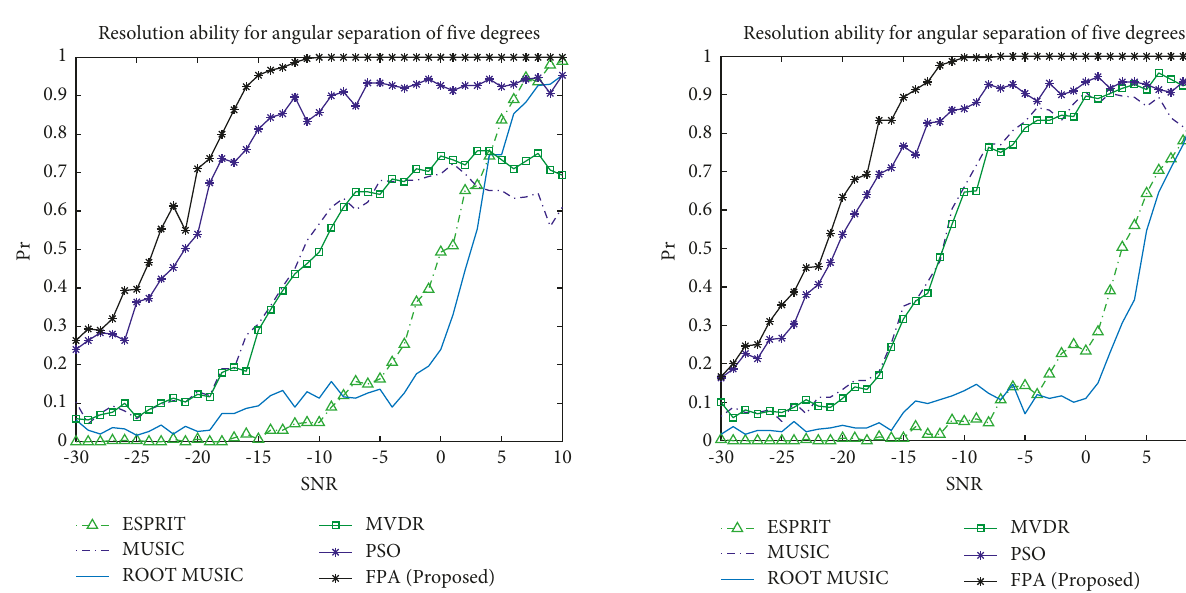
Figure 21: Probability of resolution for the source at 30 degrees.